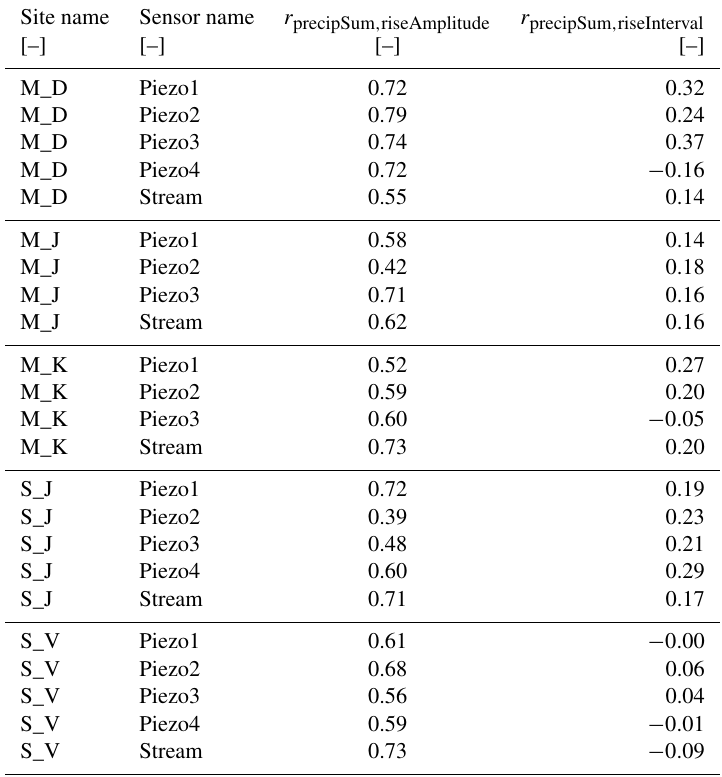
Table A1. Spearman rank correlation coefficients between event precipitation and the response variables riseAmplitude and riseInterval